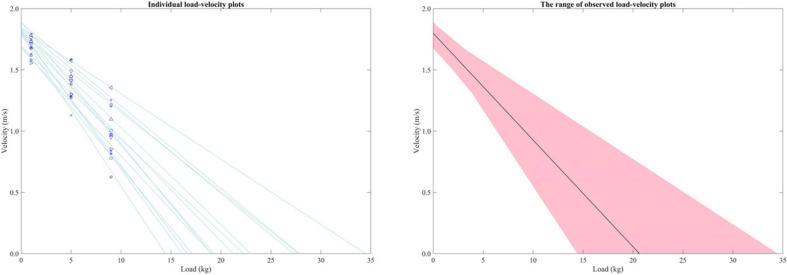
Individual load-velocity profiles obtained in the present study (left panel) and the inter-individual mean and the range of the load-velocity relationship (right panel).